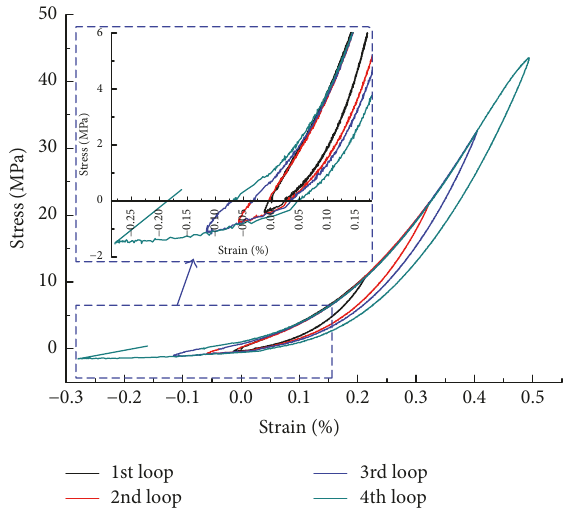
Figure 8: Stress-strain curve under incremental uniaxial compres- sive and tensile stress.